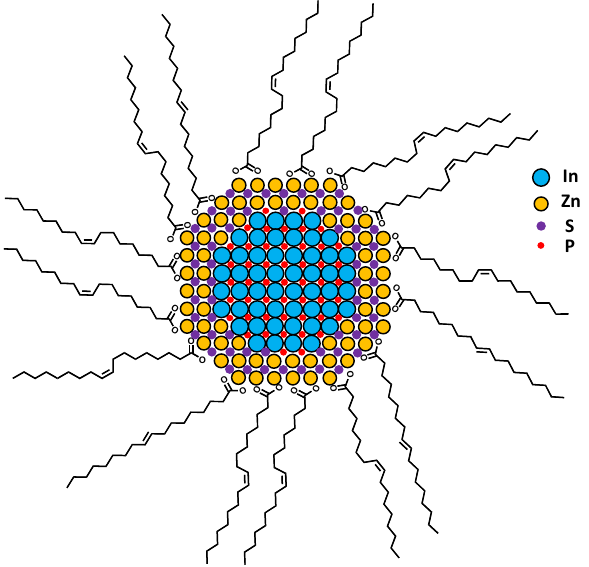
Figure 1. Schematic structure of an oleic-acid (OA) capped InP/ZnS QD with an inorganic InP/ZnS crystalline core (collection of spheres colored as designated) and OA molecules as passivating ligands (black